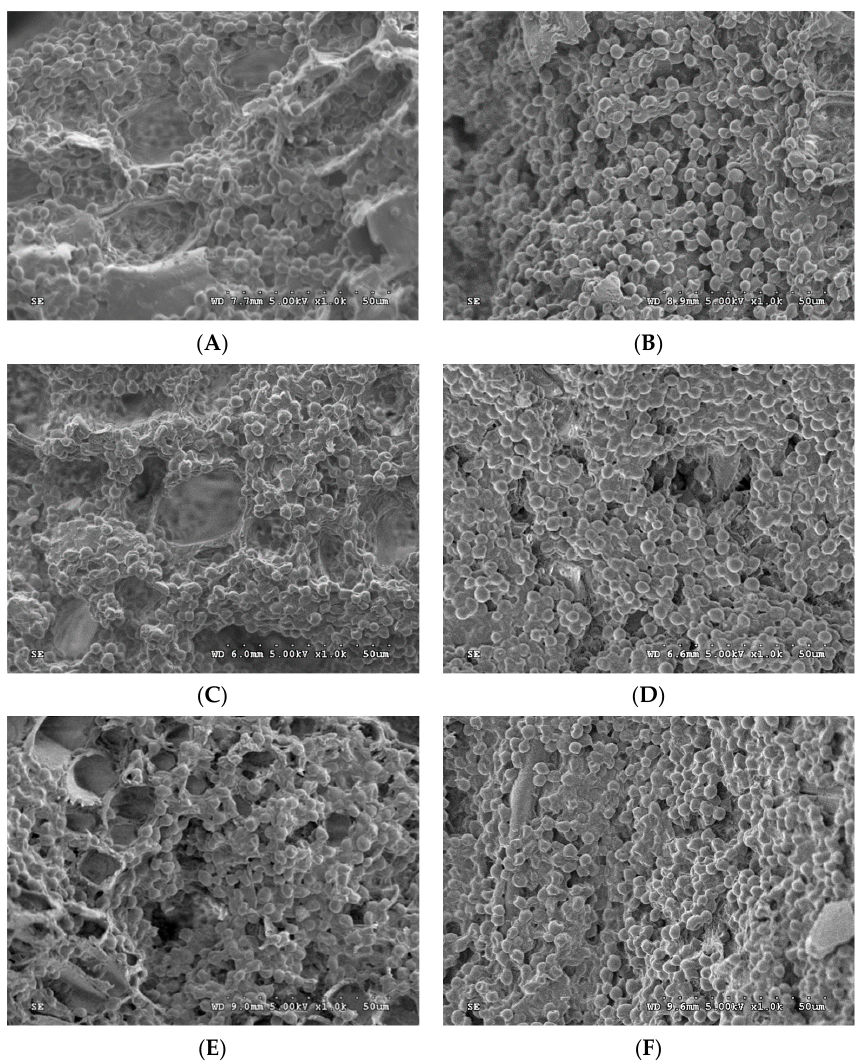
Figure 8. Scanning electron micrographs of immobilized yeast cells on rattan pieces after repeated-batch fermentation: top view ( A , C , E ) and cross-sectional view ( B , D , F ) of rattan after repeated-batch fermentation in a CR only ( A , B ), System Ⅰ ( C , D ), and System Ⅱ ( E , F ) at a magnification of 3000×. The 3D structure of rattan surfaces was observed, and the roughness of the rattan was estimated by using an AFM technique; the results are shown in Figure 9A. The roughness of the rattan surface was 0.207 ± 0.01 μ m, which is bumpier than a silicon surface (0.001 μ m) [40] and plastic surface (0.002 nm) [41]. According to the 3D digital microscopy and SEM results (Figures 2 and 3), dried rattan is very porous, resulting in high roughness. Rattan surfaces with immobilized cells after repeated-batch fermentation in System Ⅱ (Figure 9B) revealed semicircular-shaped immobilized yeast cells, as seen in the SEM results. The roughness value of the rattan with immobilized cells increased to 0.731 ± 0.03 μ m, confirming that many yeast cells were still attached to the rattan surface. Therefore, rattan, a widely available and low-cost agriculture material, is a potential carrier for cell immobilization to produce bioethanol.